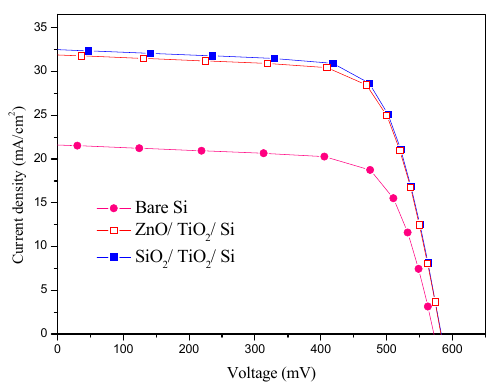
Fig. 5 . I-V curves of the solar cell with double- layer ARCs.